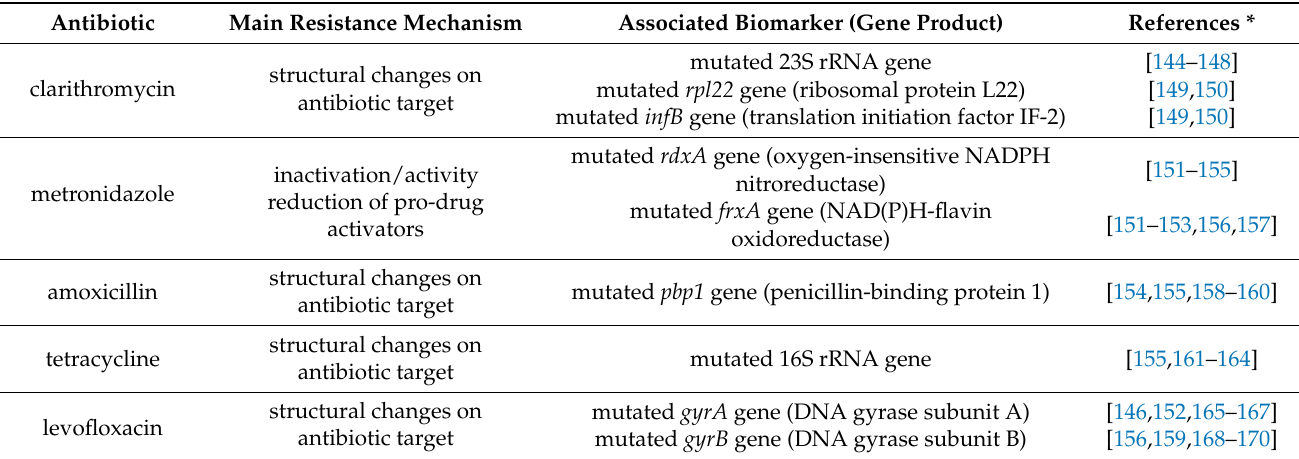
Table 2. List of consolidated biomarkers currently screened for antibiotic resistance profiling of H. pylori